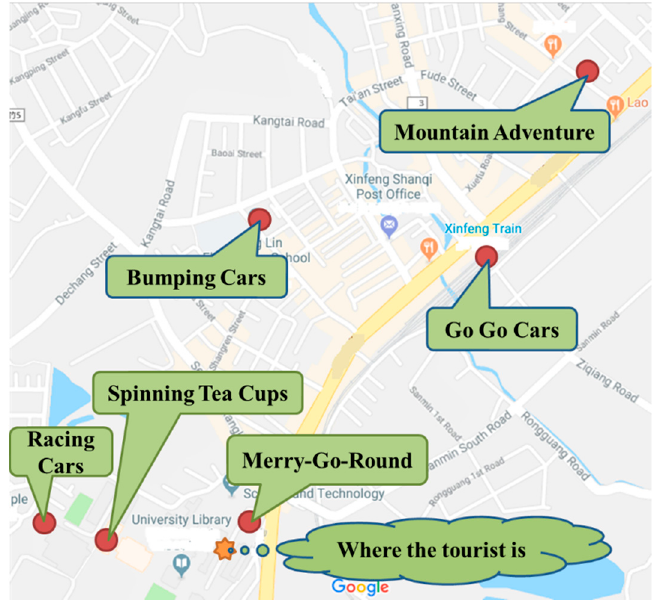
Figure 5. Field of the testing.